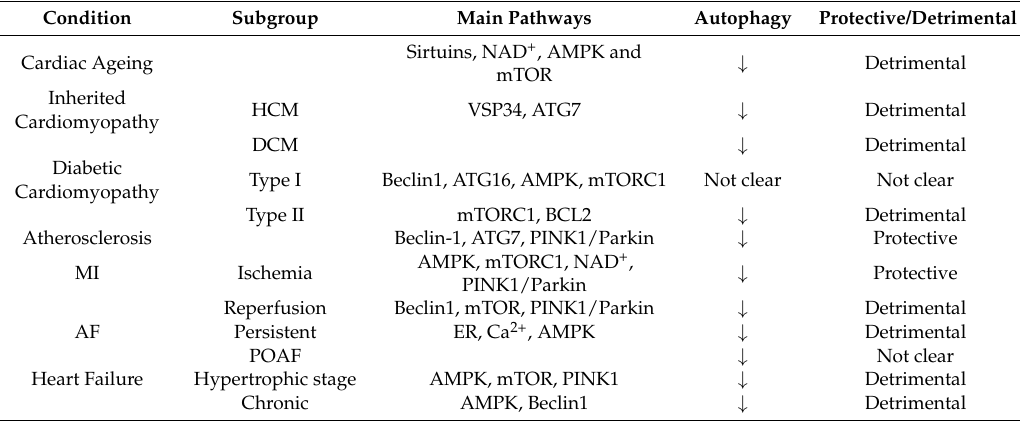
Table 1. Autophagy in cardiac ageing and